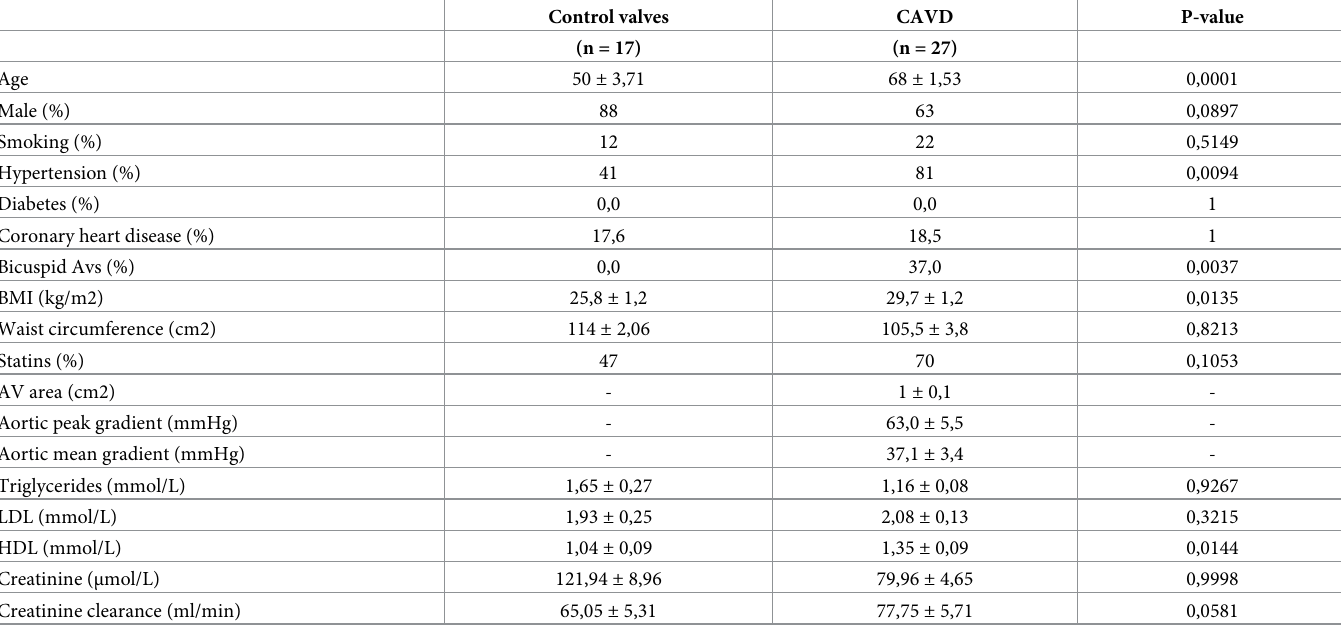
Table 1. Clinical data for control and